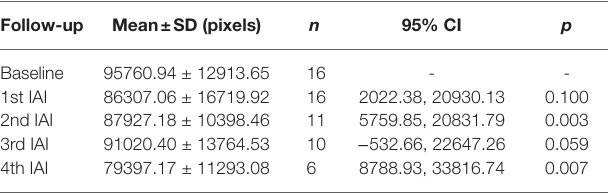
Data are number or mean ± SD. Statistically analysis was performed between baseline and each IAI. p < 0.05 was considered statistically significant. IAI, intravitreal aflibercept injection and CI, confidence